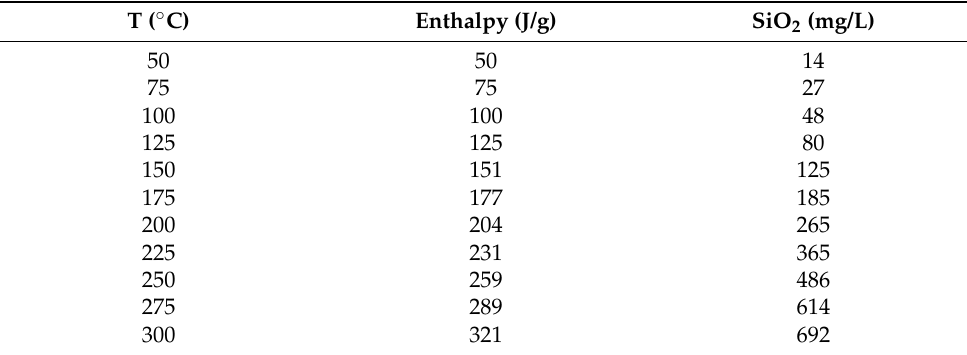
Table 7. Relationships between temperature, enthalpy and SiO 2